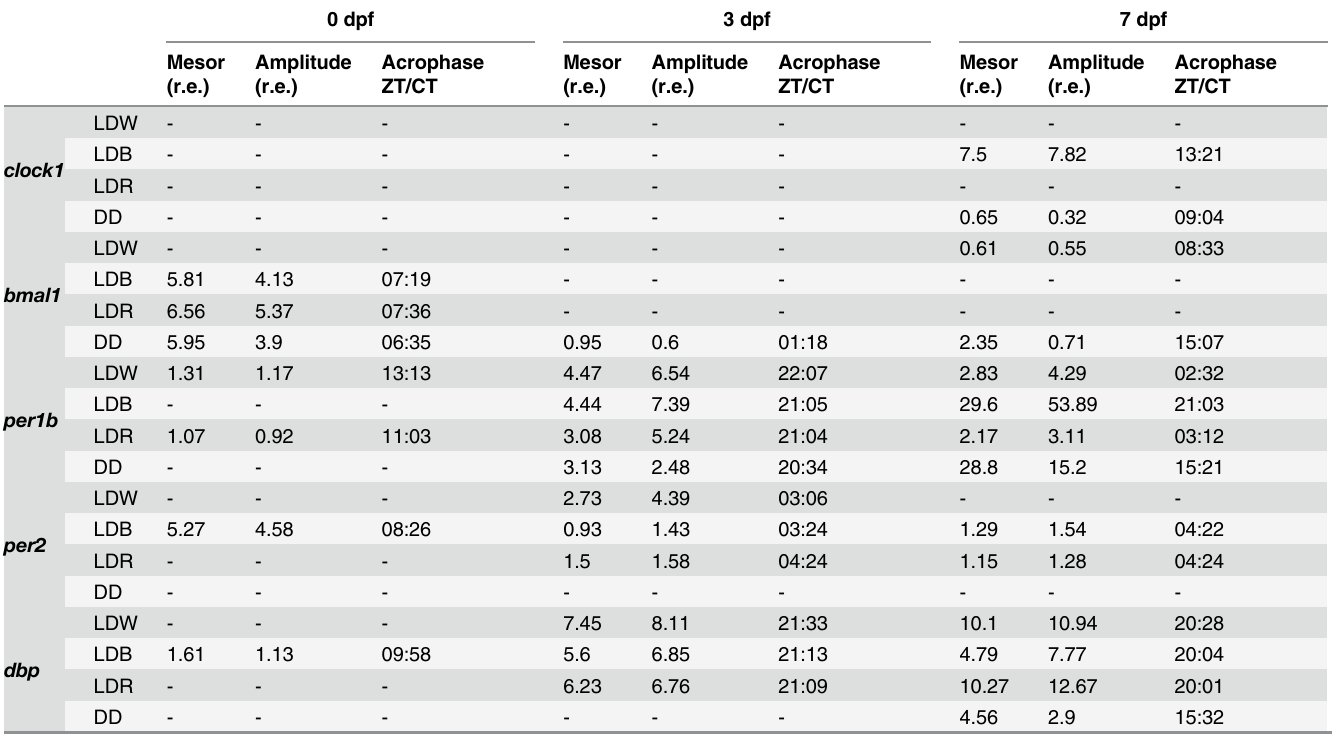
statistically signi fi cant values (p < 0.05) are